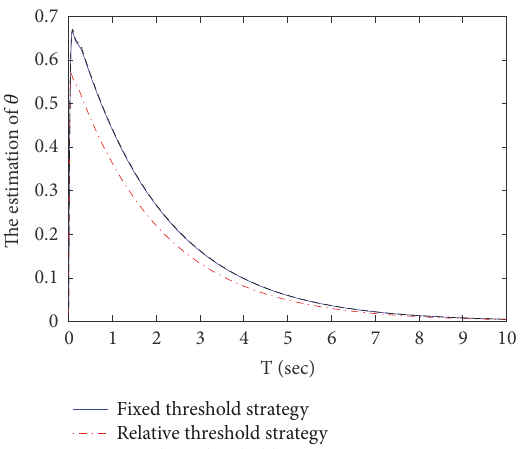
Figure 9: Parameter estimate